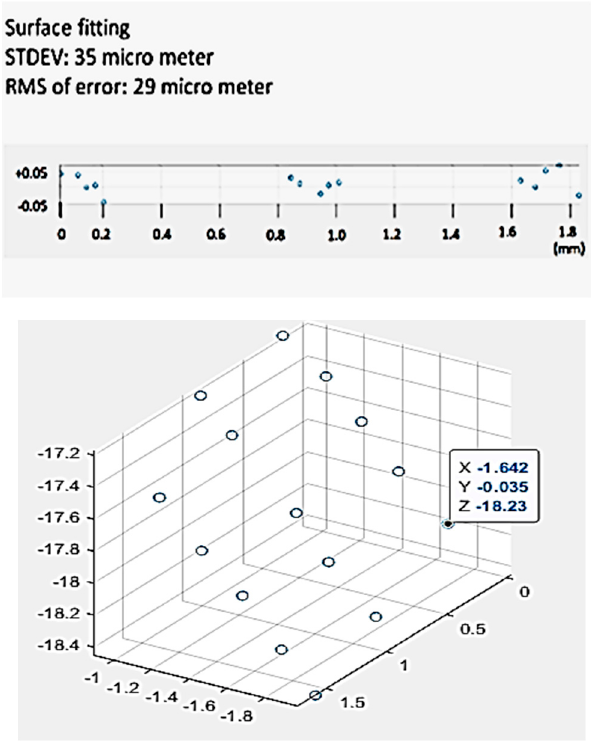
Figure 16. 3D modeling accuracy of a surface (×70).